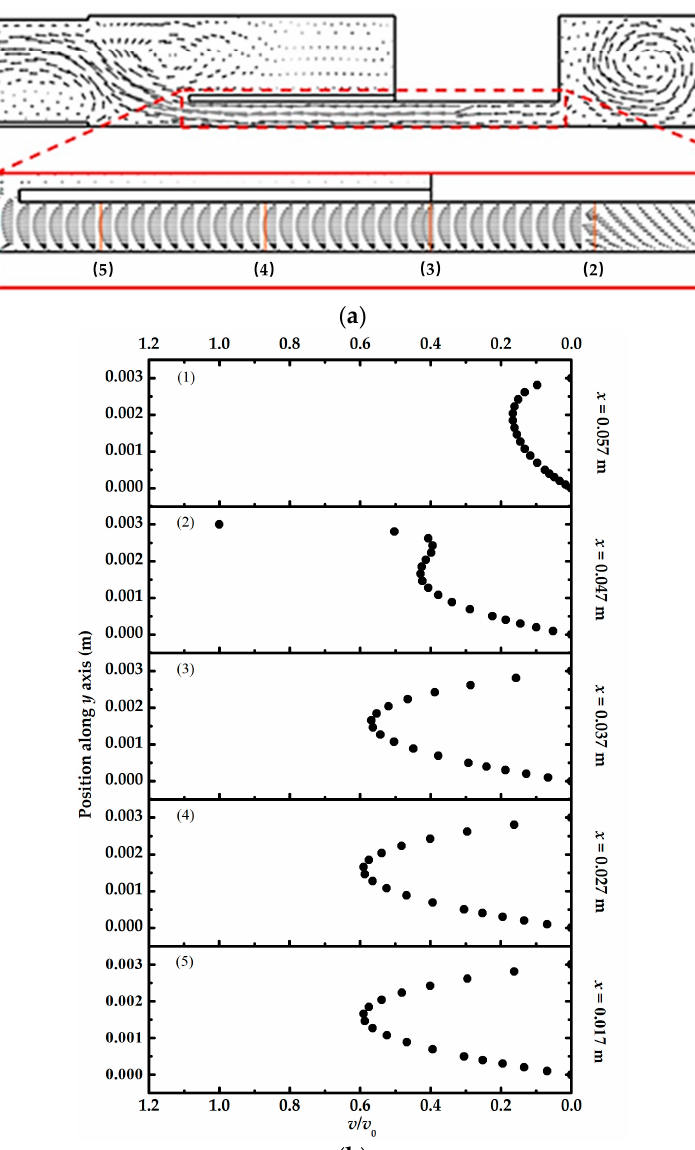
Figure 8. Under the conditions of T = 668 K, t = 60 s: ( a ) profiles of enlarged velocity field; ( b ) velocity distribution along y -axis at positions of: ( b ) (1) x = 0.057 m; (2) x = 0.047 m; (3) x = 0.037 m; (4) x = 0.027 m; (5) x = 0.017 m.